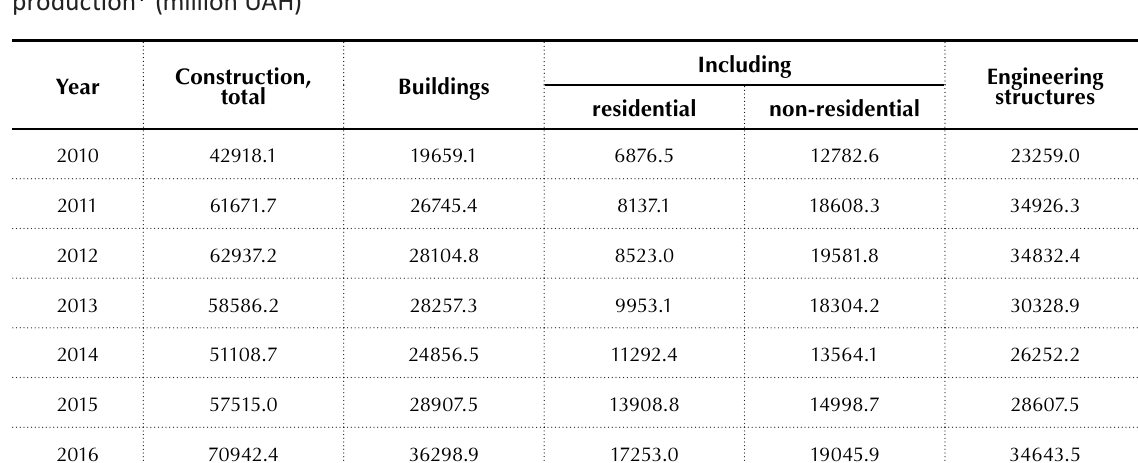
Table 1. The volume of construction works in Ukraine according to the types of construction production * (million